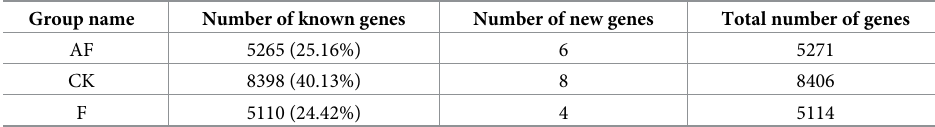
Table 2. Number of genes detected in each treatment group.